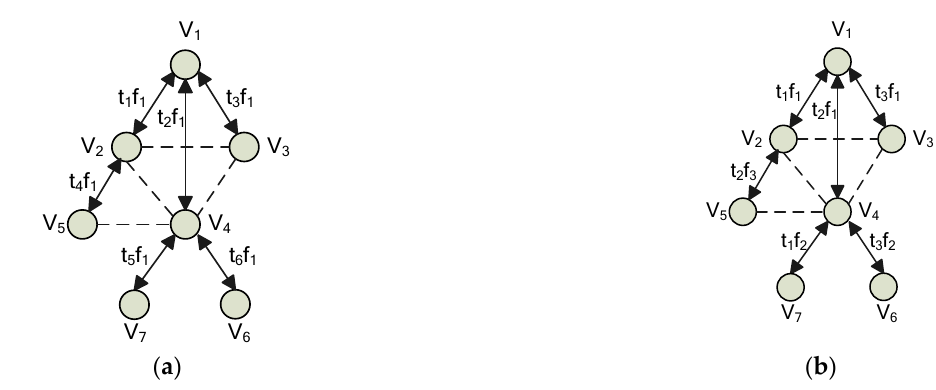
Figure 2. Example of building a routing tree. ( a ) Undirected graph G = ( V , E ) , ( b ) Routing tree T = ( V , E t ) .